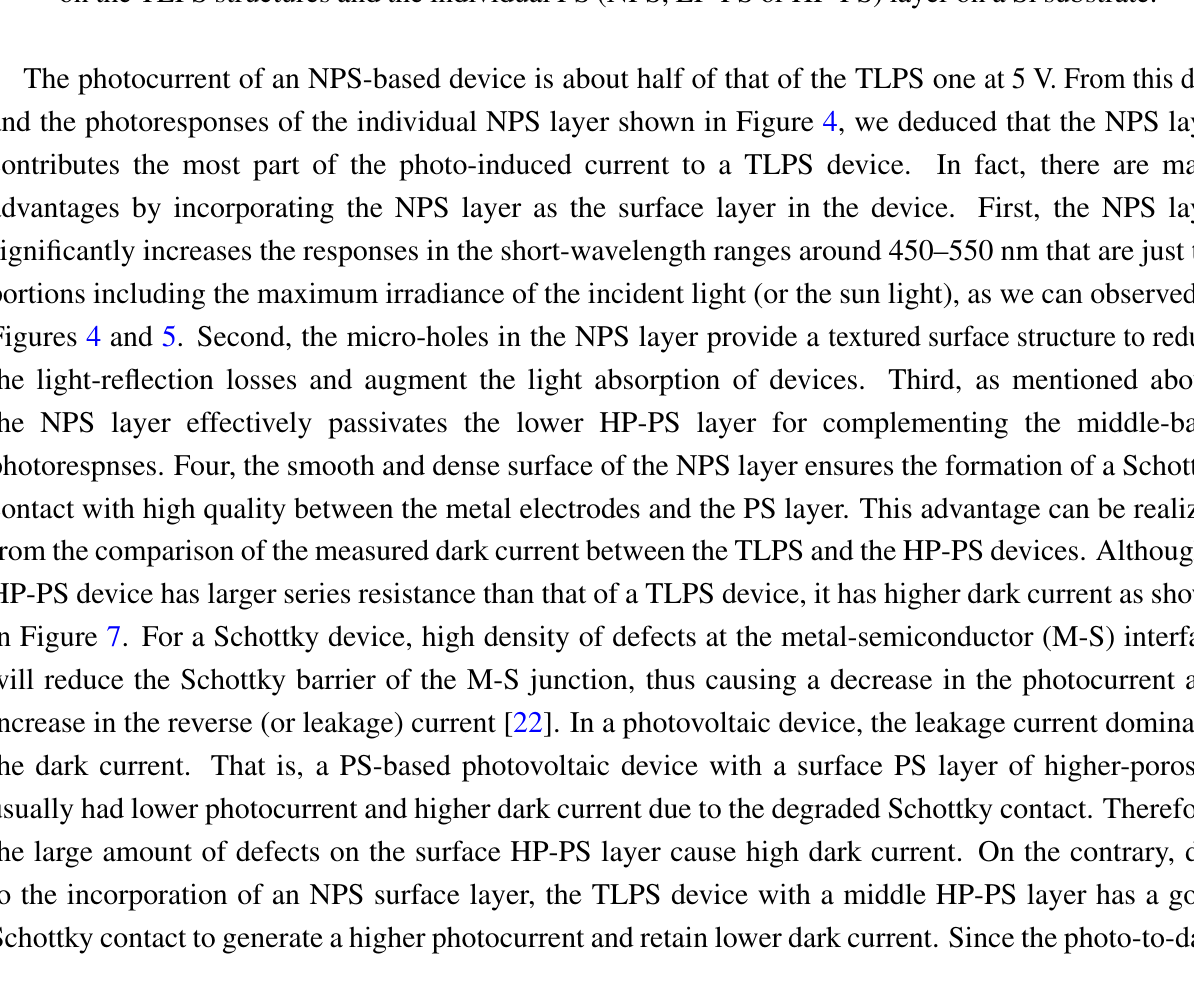
Figure 7. Photo and dark current-voltage (I–V) characteristics of photovoltaic devices based on the TLPS structures and the individual PS (NPS, LP-PS or HP-PS) layer on a Si substrate.